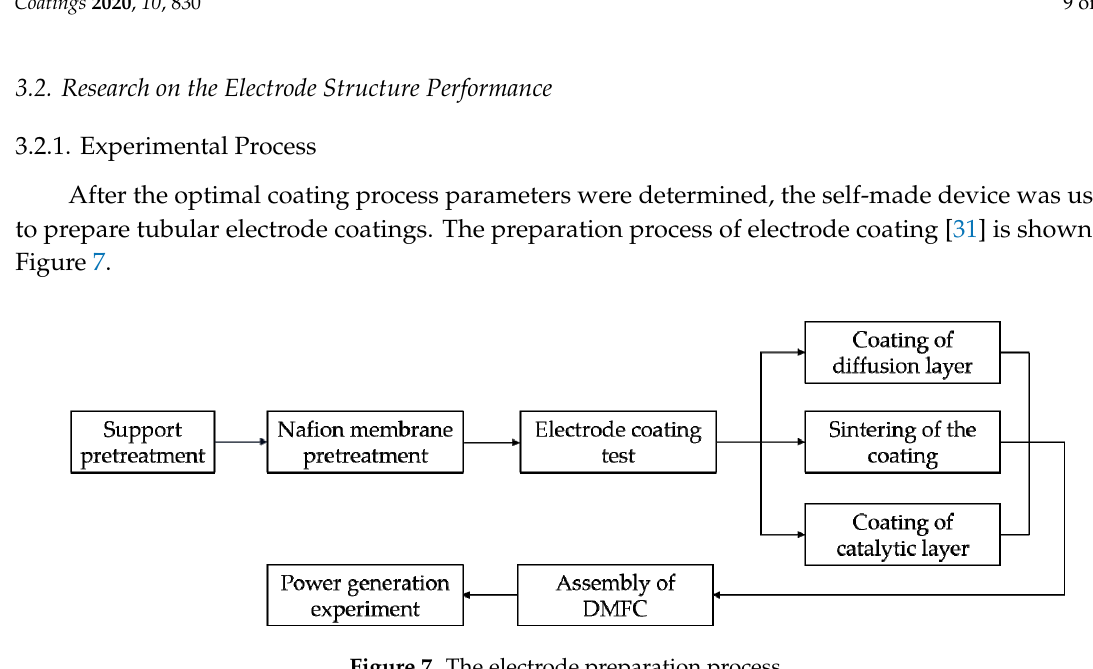
Figure 7. The electrode preparation process.